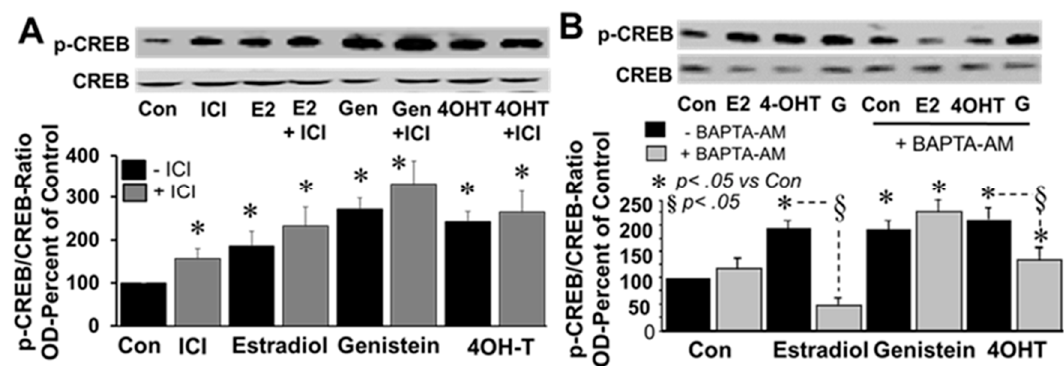
Figure 8. Panel ( A ) depicts, a representative western blot and corresponding bar graph showing the modulatory effects of the ER α / β antagonist ICI182780 (ICI; 1 µ M) on 17 β -estradiol (E2; 20 ng/mL), genistein (Gen; 20 ng/mL) and 4OH-TCB (4OHT; 20 ng/mL) induced CREB phosphorylation after treatment for 30 min. Panel ( B ) depicts a representative western blot and corresponding bar graph showing the modulatory actions of the intracellular Ca 2+ chelator BAPTA-AM (1 μ M) on 17 β -estradiol (E2; 20 ng/mL), genistein (G; 20 ng/mL) and 4OH-TCB (4OHT; 20 ng/mL) induced CREB phosphorylation in FT cells incubated for 30 min. Data (mean ± SEM) represent the mean of three different experiments ( n = 3). Results for phosphorylated CREB were normalized with non-phosphorylated CREB and expressed as percent of control. * p < 0.05 vs. untreated control, Con; § p < 0.05 vs. treatment without BAPTA-AM.